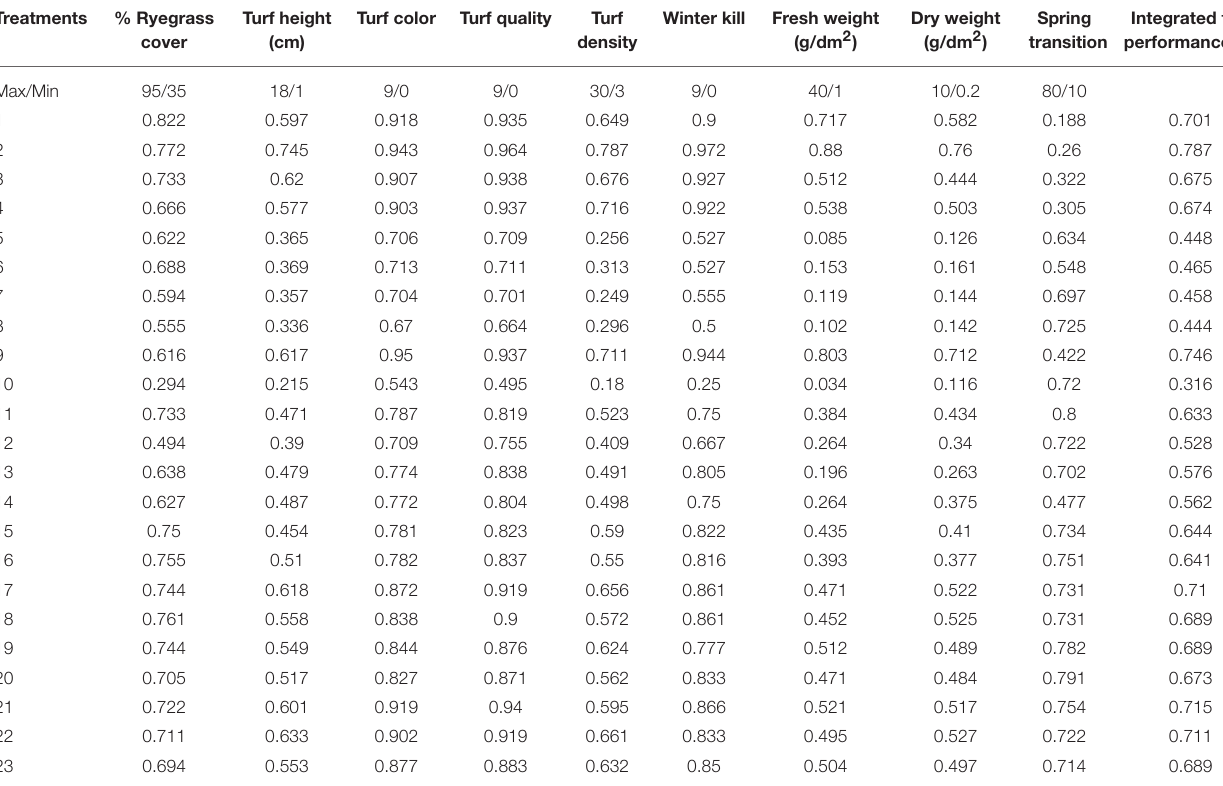
TABLE 7 | Transformed values of morphological parameters according to the central composite rotatable design and integrated turf performance (ITP) of overseeded perennial ryegrass on bermudagrass from 2014 to 2015. Treatments % Ryegrass